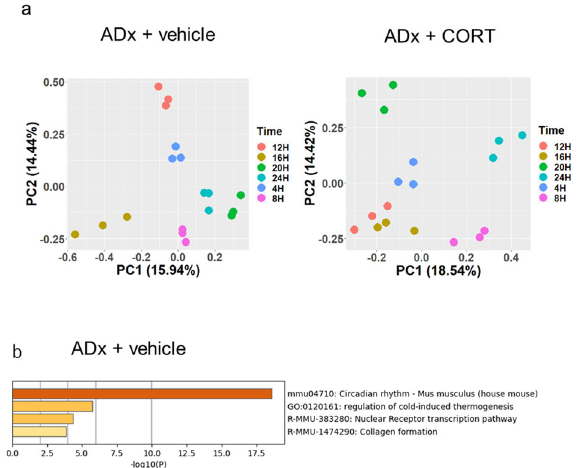
Fig. 7 Global transcriptome analysis using RNA-seq in ADx + vehicle and ADx + CORT mice. a PCA plots with N = 3 at ZT 4, 8, 12, 16, 20, and 24 in the ADx + vehicle and ADx + CORT groups, respectively. b Pathway analysis was performed using Metascape for the diurnal rhythmicity genes (de fi ned as greater than the MaxCorr of 0.85 from the cosine curve with a 1.5-fold amplitude of expression level) in the ADx + vehicle